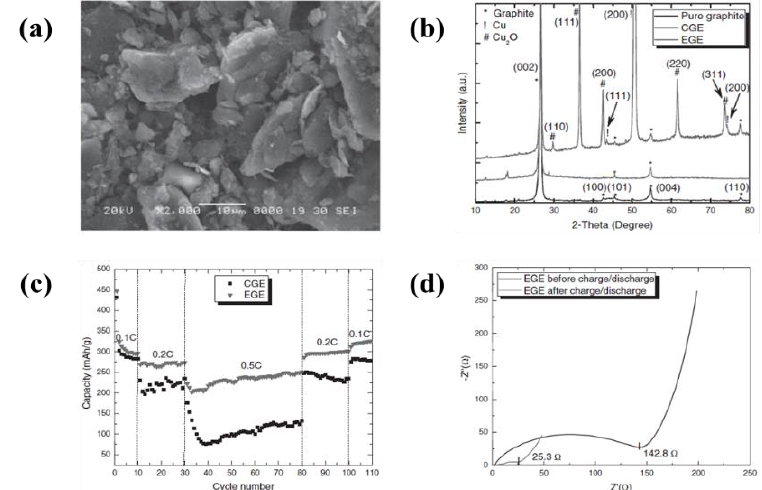
Figure 8. Binder-free graphite prepared by EPD as the anode for Li ion batteries: ( a ) Morphology of binder-free graphite; ( b ) XRD pattern of binder-free graphite; ( c ) C-rate performance of binder-free graphite; ( d ) Electrochemical impedance spectra of binder-free graphite before and after the electrochemical evaluation.